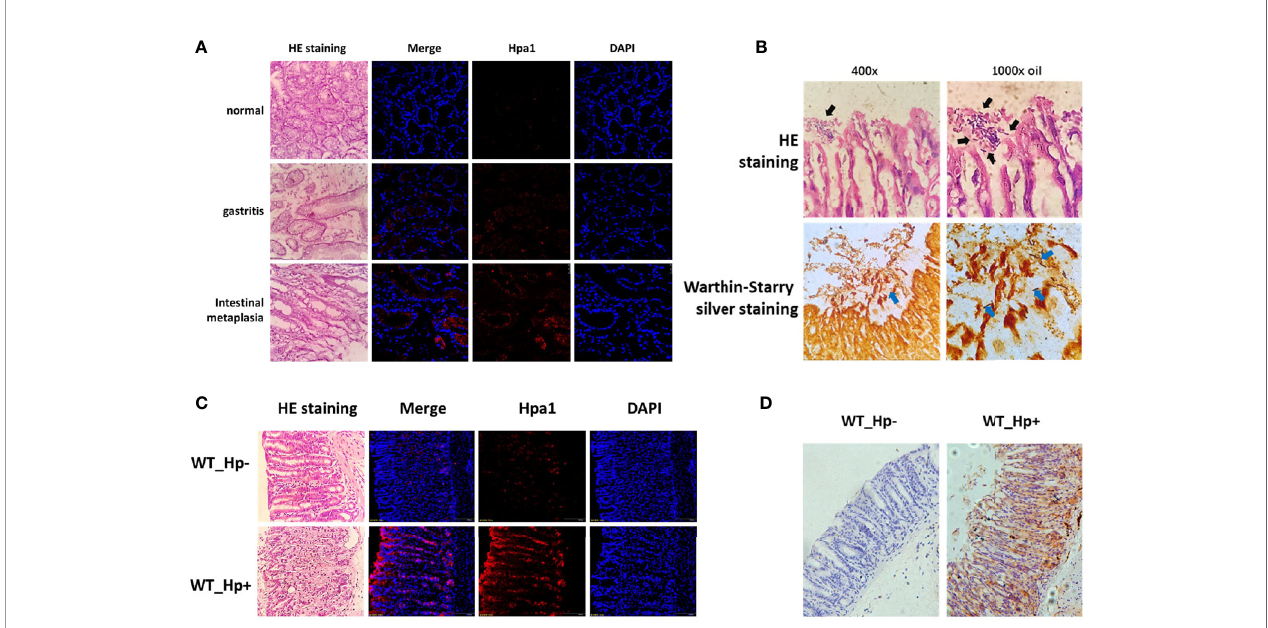
FIGURE 1 | High expression of heparanase in gastric tissue. (A) Human gastric tissue biopsies were collected during gastroscopy examination. Normal gastric tissue (gastric antrum), H. pylori -infected chronic gastritis tissue, and intestinal metaplasia tissue were included. Left panels: Hematoxylin and eosin (H&E) staining. Right panels: Immuno fl uorescent staining. Shown are representative images of immuno fl uorescent staining applying anti-heparanase antibody (red), and nuclear counterstaining (DAPI, blue). (B) H. pylori strain PMSS1 was used to infect wild type C57BL/6 mice via oral gavage, once every 2 days, 5 × 10 9 CFU each time, for three consecutive times. Eight weeks later, antral gastric mucosa was collected and 5-micron sections were subjected to H&E (upper panels) and Warthin – Starry silver (lower panels) staining, which indicates successful infection of H. pylori . Black and blue arrow indicate the colonized helicobacter pylori. (C) Immuno fl uorescent staining of normal mouse gastric tissue and mouse H. pylori -infected chronic gastritis tissue. Left panels: Hematoxylin and eosin (H&E) staining. Right panels: immuno fl uorescent staining. Shown are representative images of staining for heparanase (red), and nuclear counterstaining (DAPI, blue). (D) Immunostaining of WT (un-infected) mouse gastric tissue (left panel) and H. pylori -infected chronic gastritis tissue (right